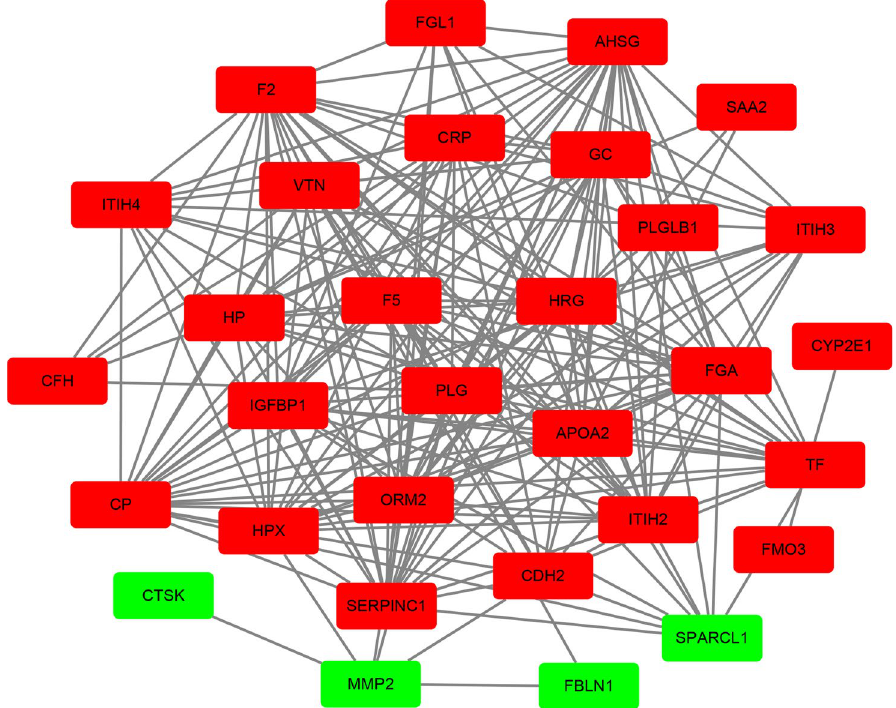
Figure 3. Protein–protein interaction network of proteins encoded by differentially expressed genes between primary tumor tissues and metastasis tumor tissues. Red nodes represent upregulated genes, whereas the green ones represent downregulated genes.